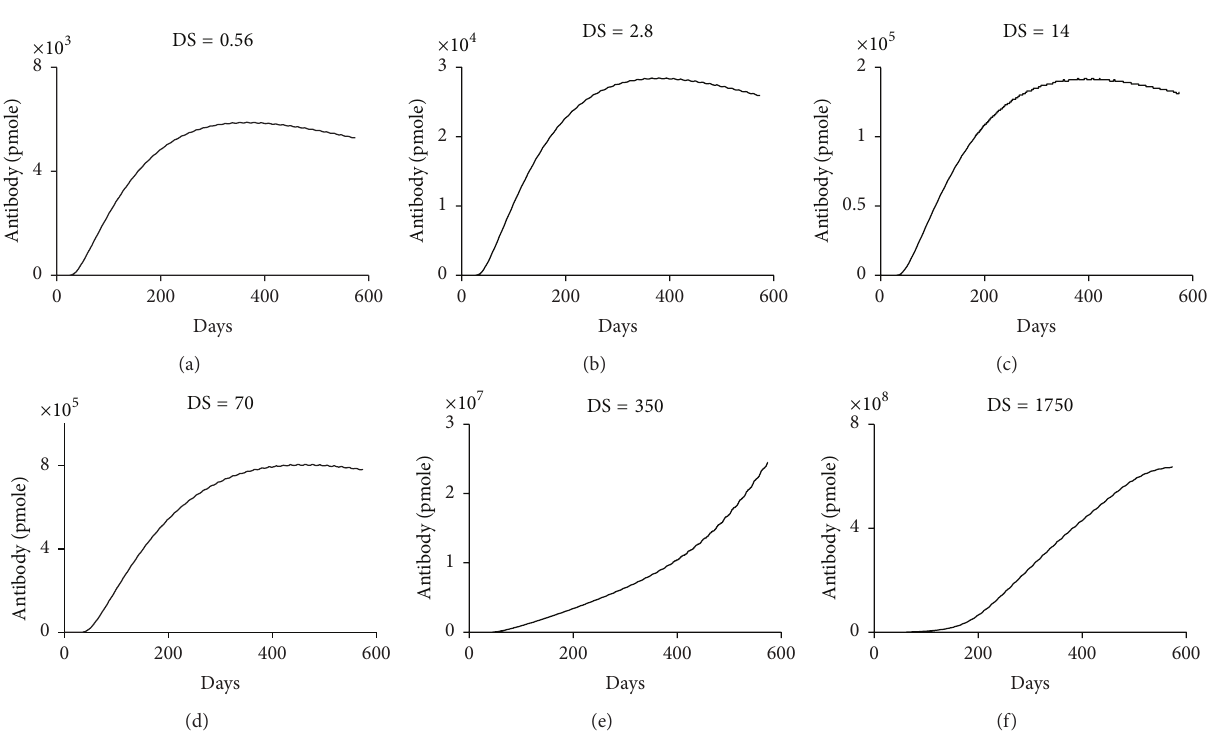
Figure 4: Aggregates could contribute to ADA production by increasing danger signal to maturate dendritic cells. ((a)–(f)) Simulated ADA production is shown at various levels of danger signal (DS) which is modeled as the amount of LPS in ng. Remaining parameter values are the same as in the original simulation for nonaggregated adalimumab [47, 48]. DS = 350 ng LPS shows the original simulation for nonaggregated adalimumab [47, 48]. ADA production is shown as the sum of the 17 subgroups. Dose = 40 mg administered